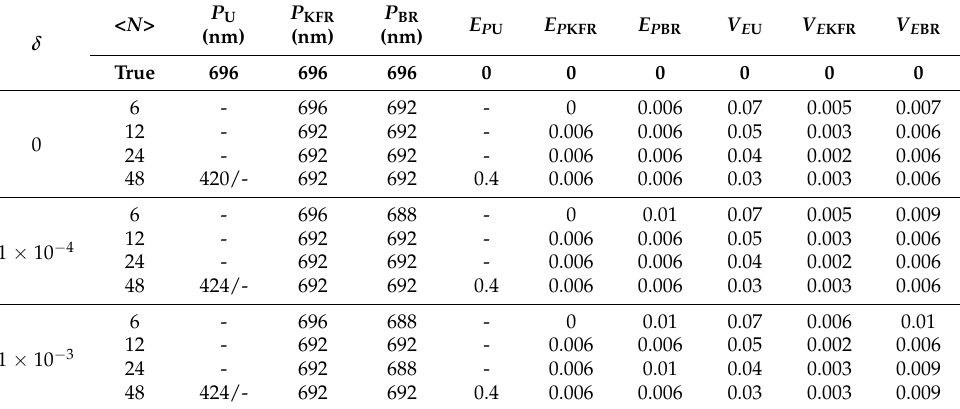
Figure 8. PSD recovered by the KFR method for a 696 nm unimodal sample at number concentrations of < N > = 6, 12, 24, 48, and different levels of noise. ( a ) 0, ( b ) 10 − 4 , ( c ) 10 − 3 , ( d ) 10 − 2 , and ( e ) 10 − 1 noise levels. Table 4. Performance indices for the recovery of the 696 nm PSD by using three